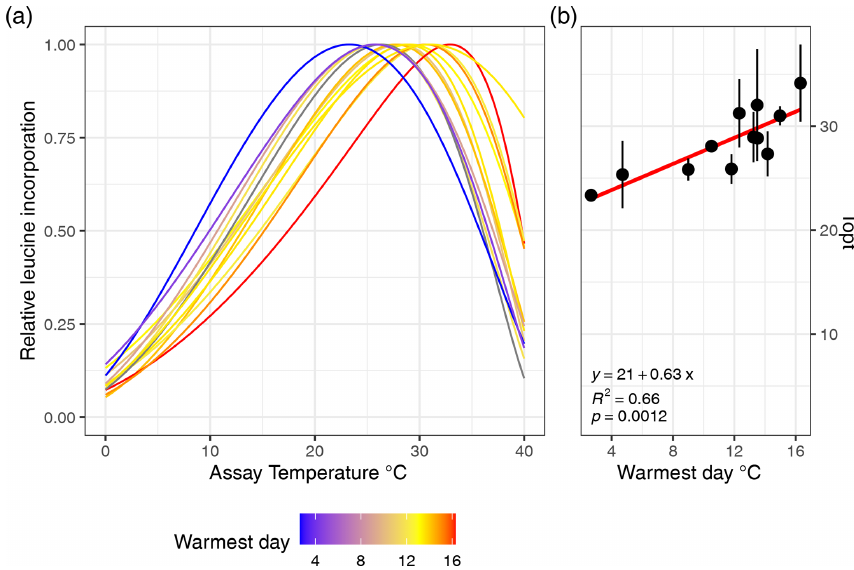
Figure 2. (a) Estimated growth curves for each soil type depicted by the normalized leucine incorporation over incubation temperature. Colors indicate the maximum soil temperature of each sampling site. (b) Linear relationships between the optimal growth temperature and maximum soil temperature are shown, and the error bars indicate the standard error.